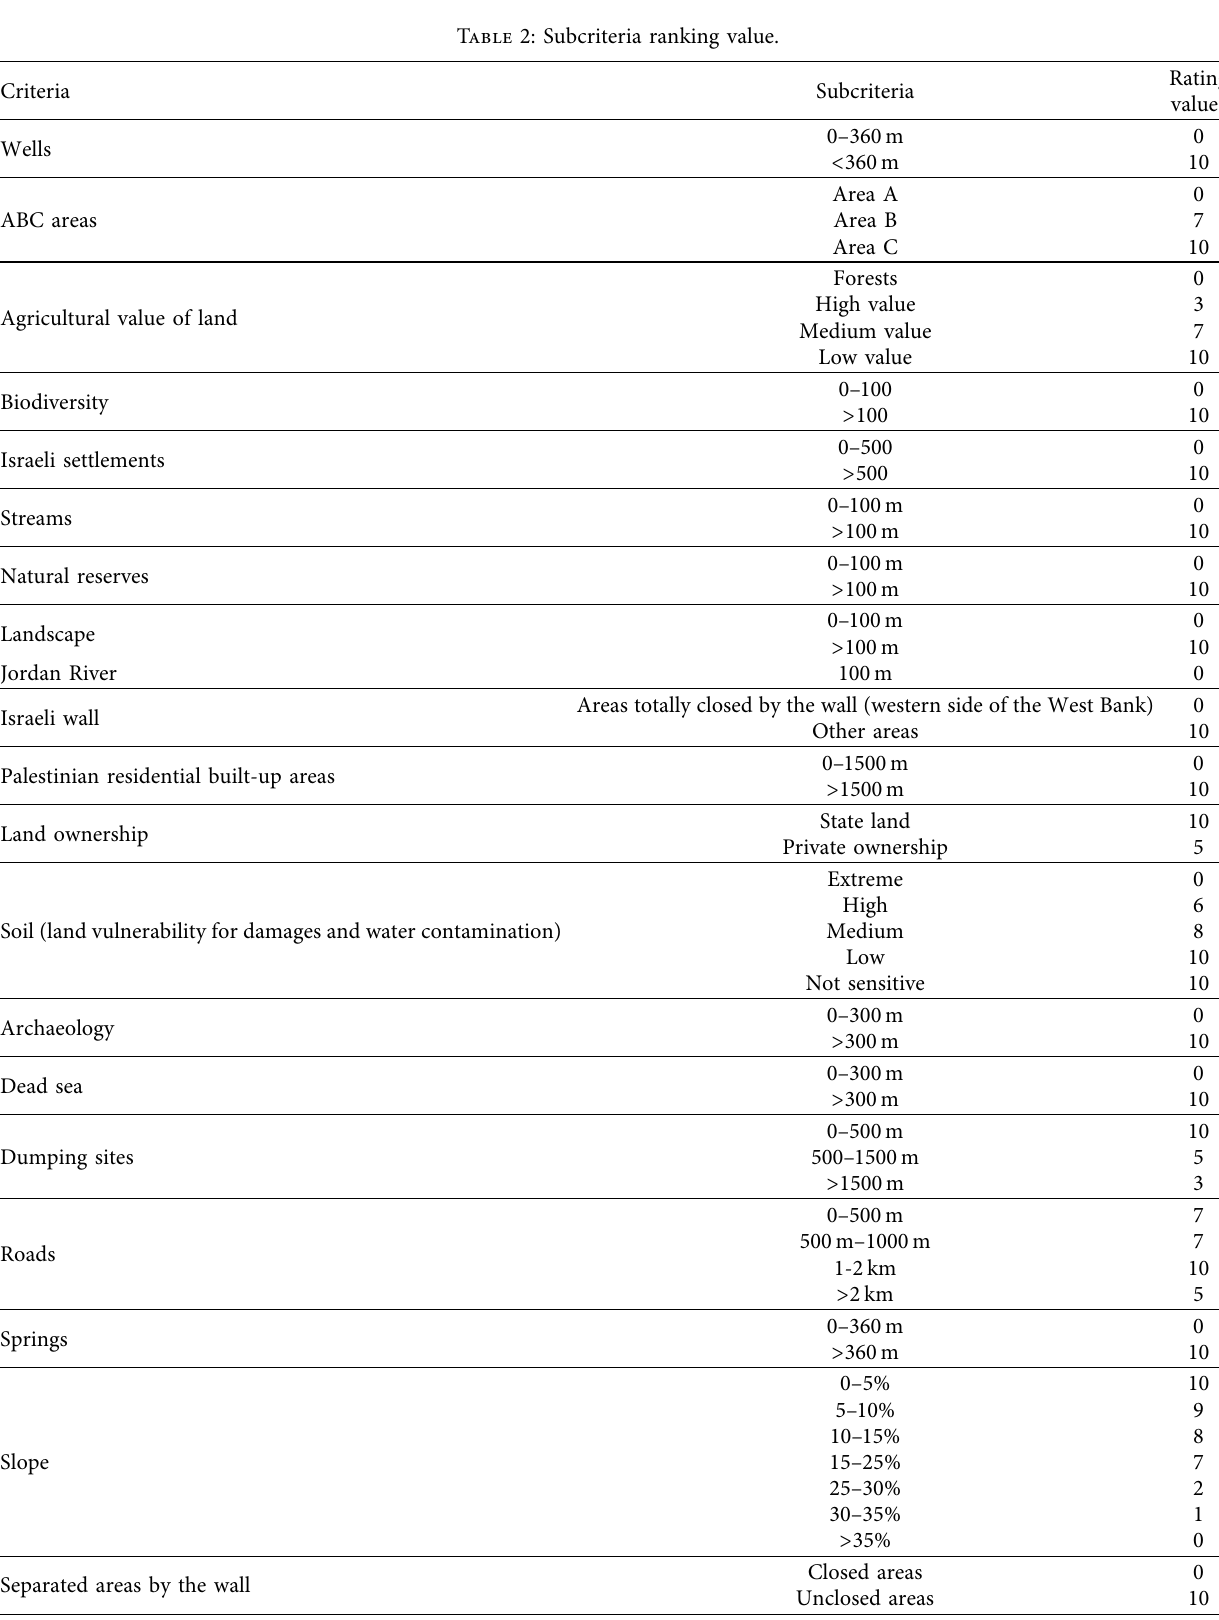
Table 2: Subcriteria ranking